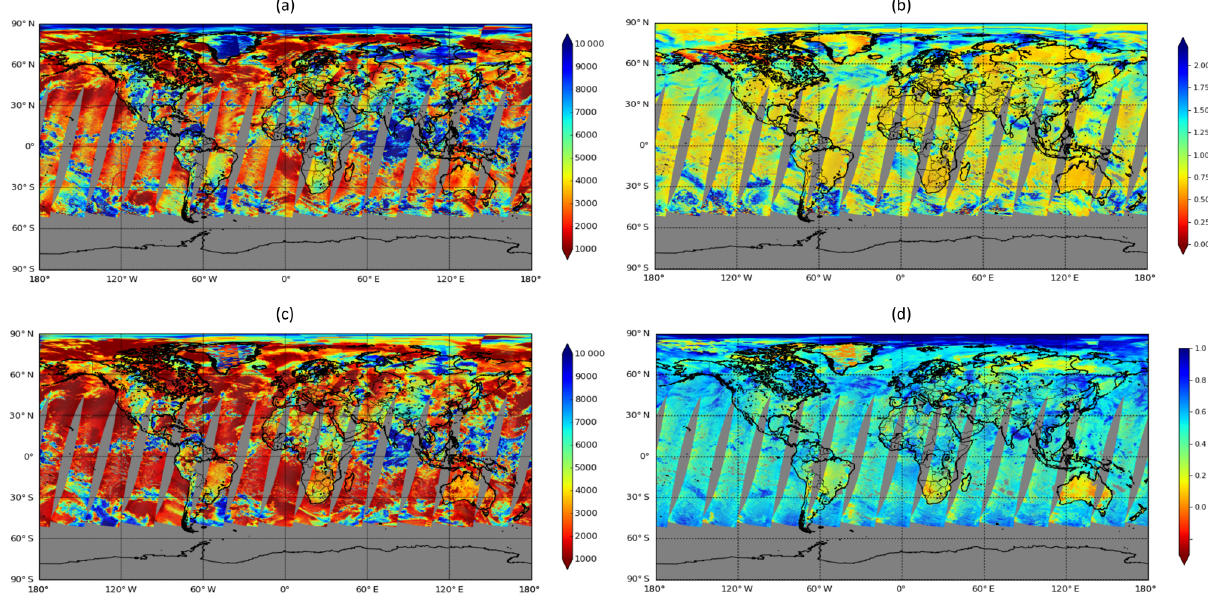
Figure 12. Cloud top height (a) and cloud optical thickness (b) retrieved with ROCINN_CAL, cloud height (c) and cloud albedo (d) retrieved with ROCINN_CRB from GOME-2A measurements on 1 July 2012. The cloud height is displayed in metres, and a logarithmic scale is used for the optical thickness.